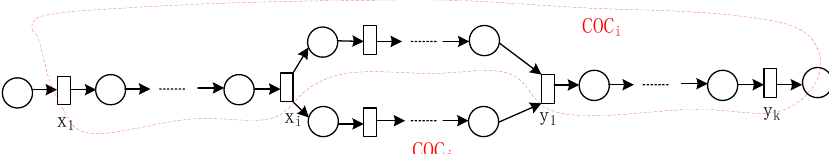
Figure 9. Typical concurrent substructure composed of COC i and COC j